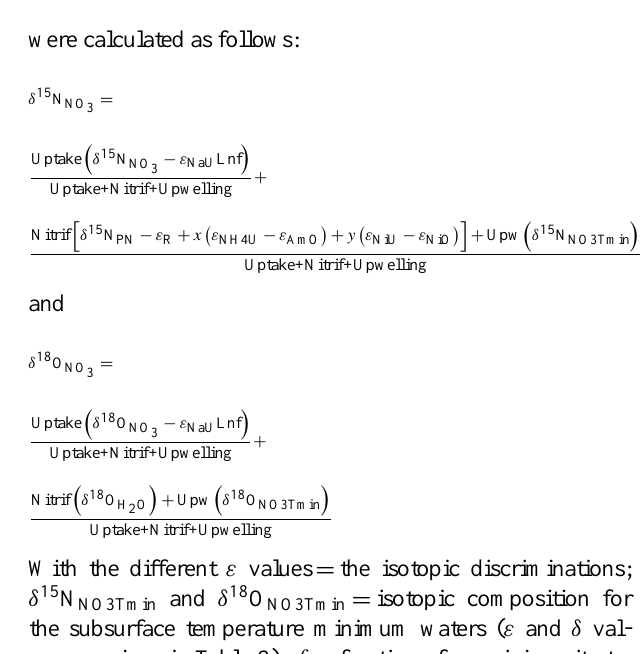
= 5‰ and δ 18 O = 2‰ in the case that the 15 N / 14 N NO 3 3